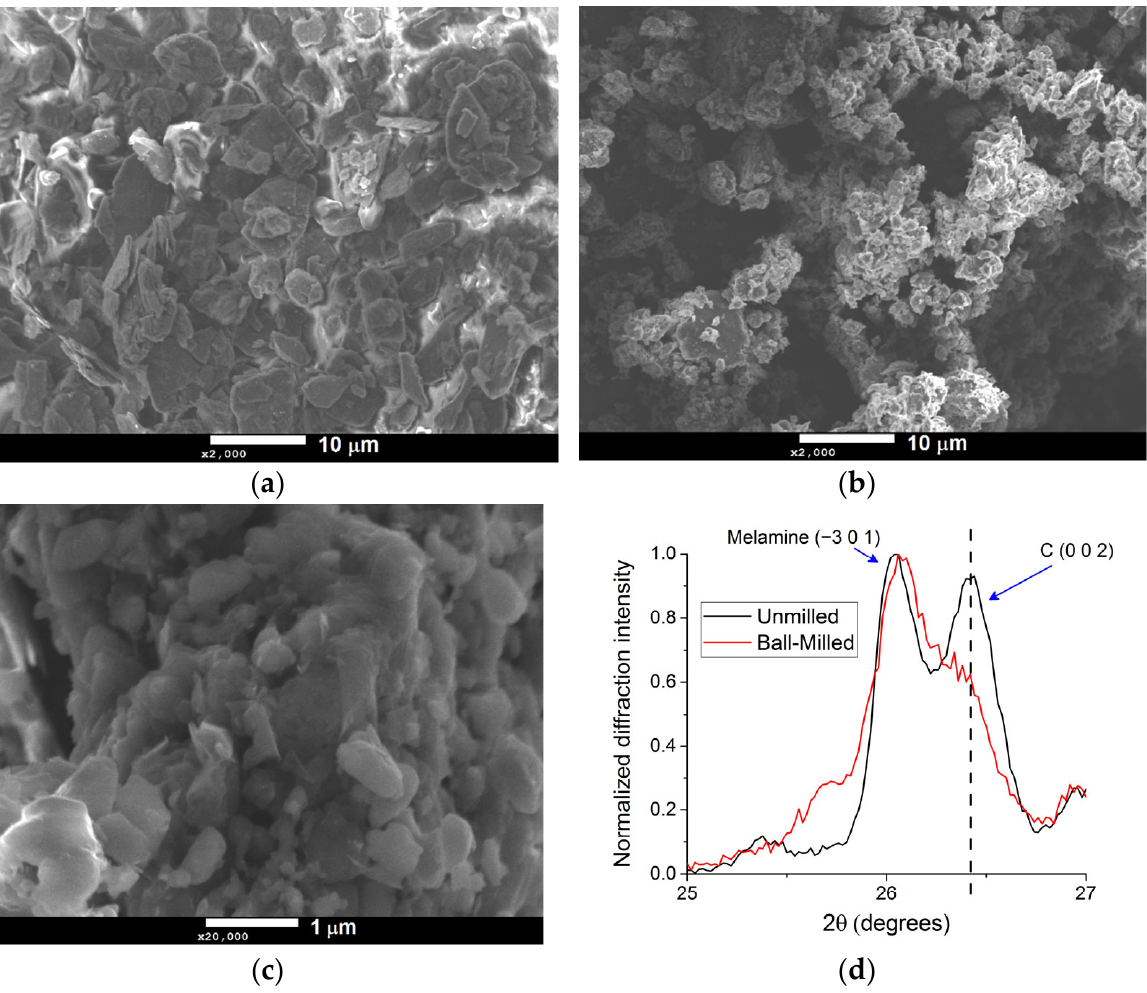
Figure 1. ( a ) SEM image of unmilled graphite/melamine, ( b ) SEM image of milled Graphite/melamine sample, ( c ) SEM image of milled Graphite/melamine sample at a higher magnification and ( d ) Comparison of the XRD patterns of unmilled (black line) and milled (red line) samples. The dash line indicates the position of the C (002) pattern.